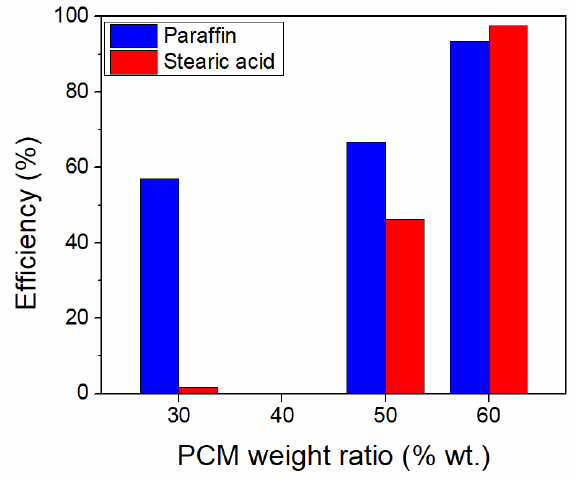
Figure 6. Comparison of the heat storage efficiency of paraffin and stearic acid-silica composites obtained through one-pot sol-gel synthesis. Data from ref. [85].